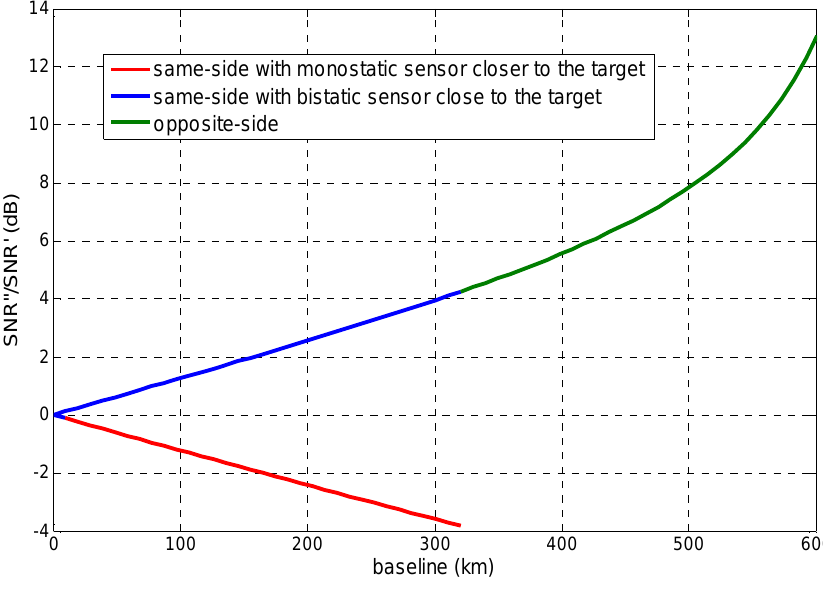
Figure 4. Ratio between bistatic and monostatic SNR for different observation strategies as a function of the baseline (platforms operating at 620 km altitude in parallel